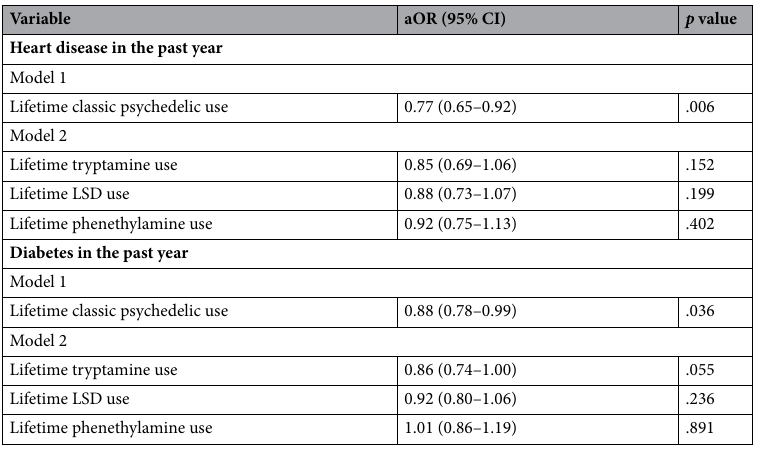
Table 2. Lifetime classic psychedelic use and cardiometabolic diseases. The number of observations in the models with heart disease in the past year as dependent variable was 375,473; the number of observations in the models with diabetes in the past year as dependent variable was 375,434; aOR adjusted Odds Ratio, CI confidence interval. Odds ratios were adjusted for age, sex, ethnoracial identity, educational attainment, annual household income, marital status, self-reported engagement in risky behavior, lifetime use of cocaine, other stimulants, sedatives, tranquilizers, heroin, pain relievers, marijuana, phencyclidine (PCP), 3,4-methylenedioxymethamphetamine (MDMA/ecstasy), inhalants, smokeless tobacco, pipe tobacco, cigar, and cigarettes daily, and age of first alcohol use; see Supplementary Table S1 for additional